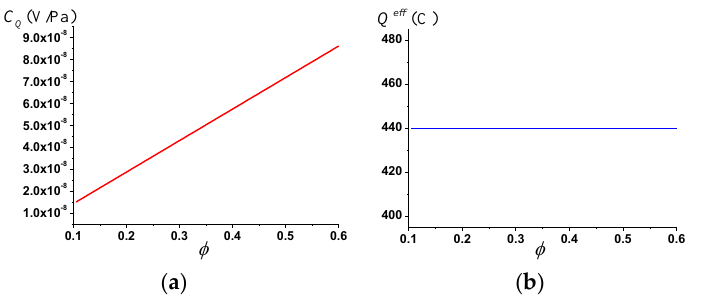
Figure 2. Effect of pore size (steady case): ( a ) streaming potential coupling coefficient; ( b ) effective net residual charge density.